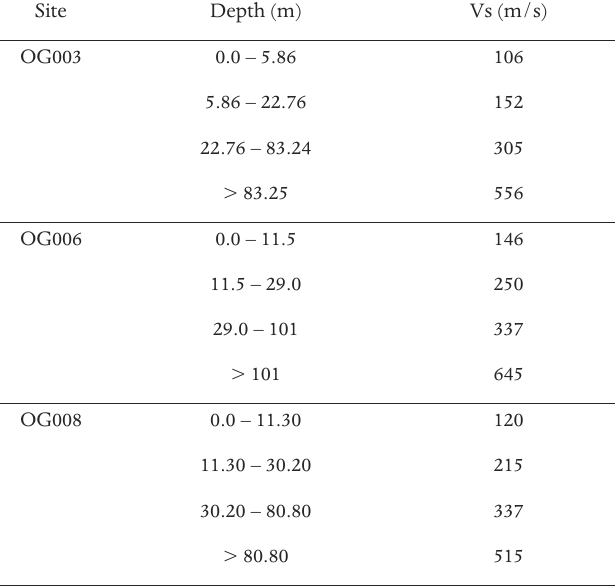
Table 2. Velocity and depth estimates using the extended spatial autocor- relation method at the OG003, OG006 and